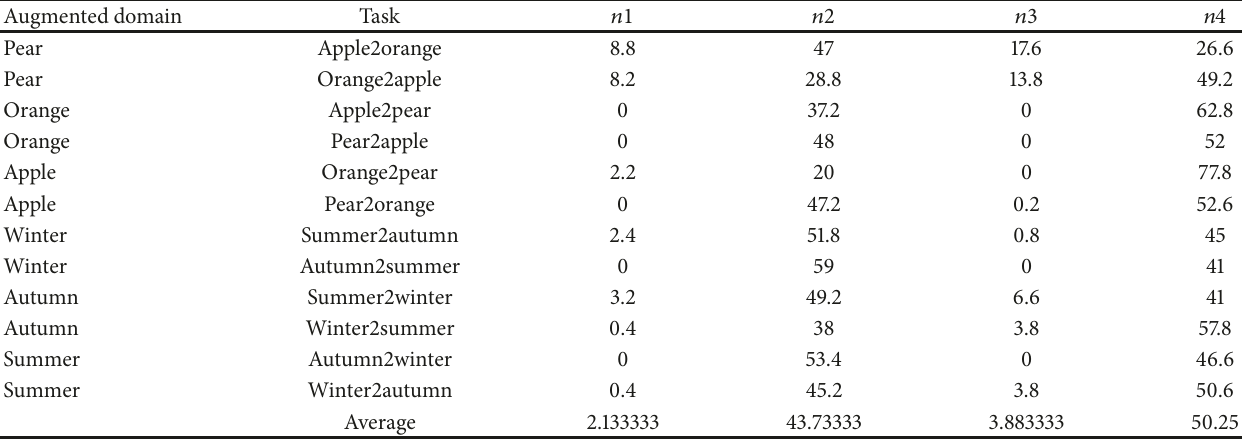
Table6:ThistableshowsthattheresultsofUNITVSMMGANs,inwhichthethirdandthefourthcolumn,respectively,representapercentage of better quality of generated images by UNIT and MMGANs. The last two columns mean the generated images by the two models generated good images and bad images in the testing